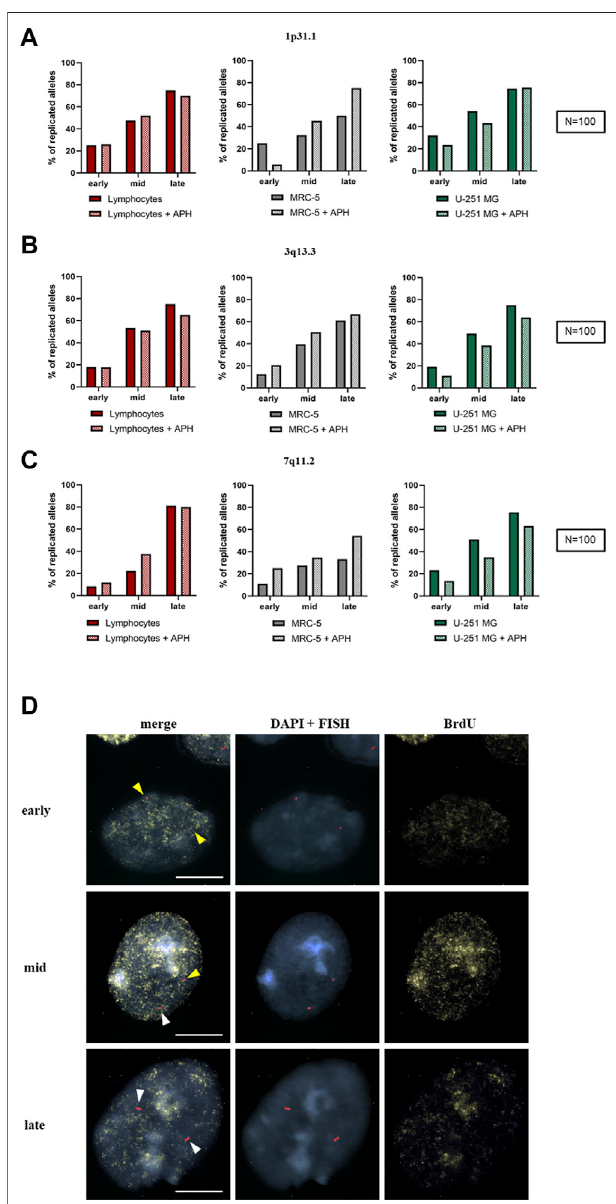
FIGURE7| ReplicationtimingofthreeCFSsinlymphocytes (red), MRC- 5 fi broblasts (gray), and U-251 MG GBM cells (green). The graph represents the replicated alleles in each substage of the S-phase for 1p31.1 (A) , 3q13.3 (B) , and 7q11.2 (C) . Example of nuclei stained with DAPI (blue), FISH spots for 3q13.3 with probe RP11-324H4 (red), and BrdU (yellow) as indicated, and merge (left) of early, mid, and late S-phase stages (D) . Non- replicated alleles are single spots (yellow arrows), while replicated alleles are doublespots(whitearrows).Numberofcountednucleiwas100undercontrol and APH treatment ( N (cid:1) 100) for one replicate. Scale bar: 10